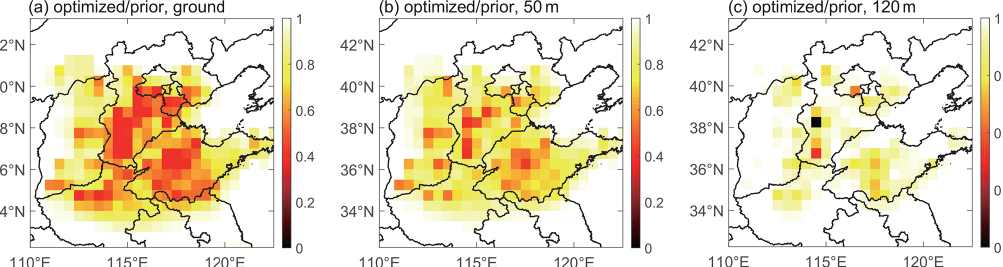
Figure 6. The ratio of optimized emissions to prior emissions (optimized emissions divide by prior emissions). (a) Non-point source on the ground, (b) middle-elevation point source at 50m and (c) high-elevation point source at